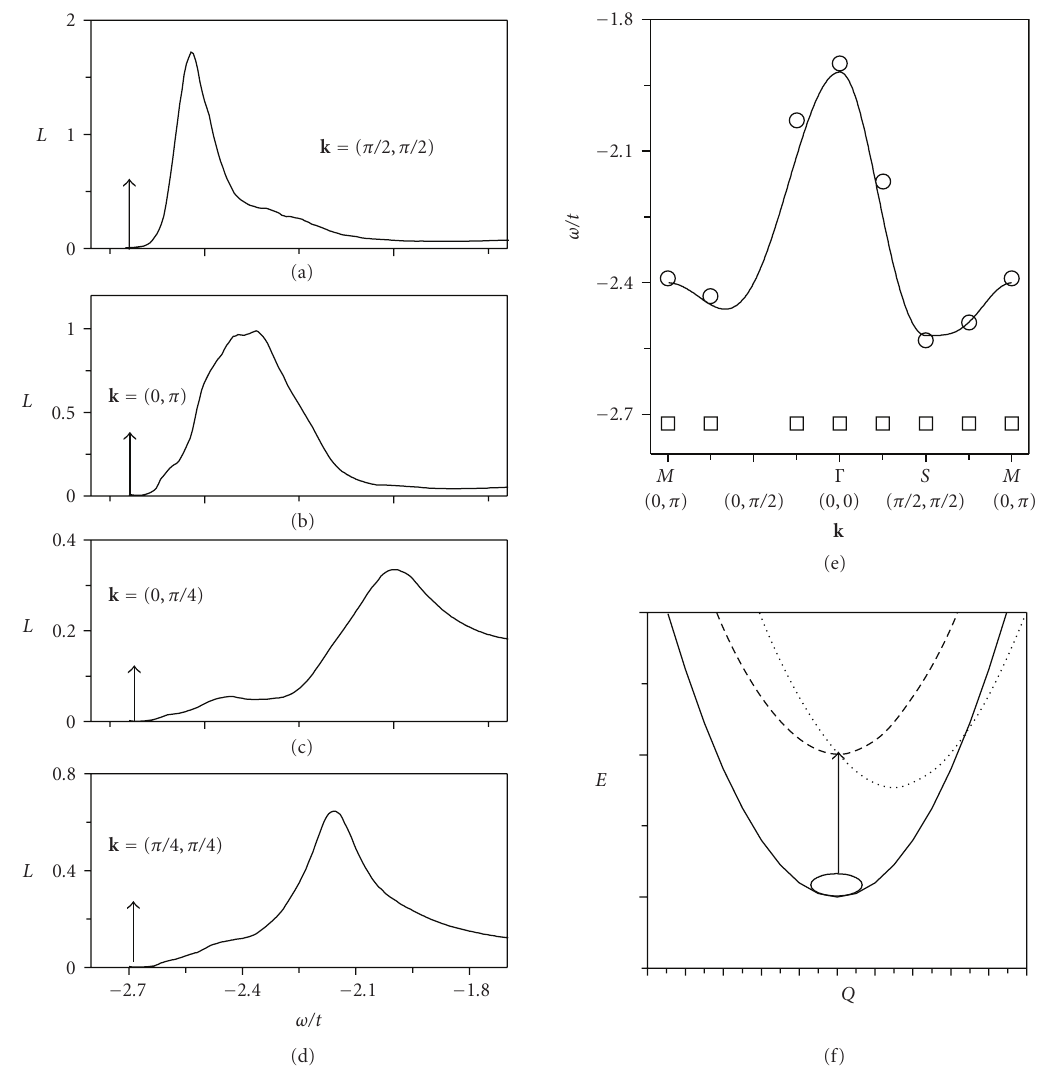
Figure 4: Low-energy part of the spectral function of the hole at J/t = 0 . 3 and λ = 0 . 46 (a)–(d). The vertical arrows in (a)–(d) denote the position of the quasiparticle invisible in the scale of the figure because of low weight. (e) Dispersion of resonances at J/t = 0 . 3: broad resonance (circles) and the quasiparticle with small weight (squares) at λ = 0 . 46. The solid line is the dispersion of the hole (8) in the pure t-J model at J/t = 0 . 3 ( W J/t = 0 . 3 = 0 . 6) and ε min = − 2 . 52. Panel (f) shows the potential of ground state Q 2 / 2 (solid line), potential of the excited state without the lattice relaxation (dashed line), and potential of the excited state after the lattice relaxation D + ( Q − λ ) 2 / 2 − λ 2 / 2 (dotted